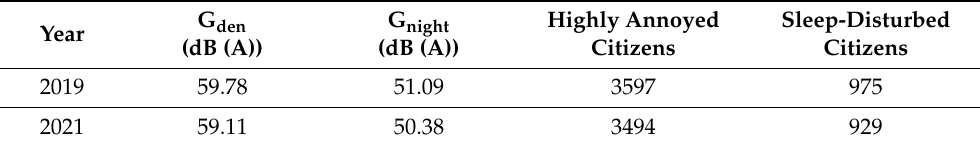
Table 3. G den and G nigh , total citizens of Piombino highly annoyed and sleep-disturbed in 2019 and 2021 with double-layer ZOAB pavements on three